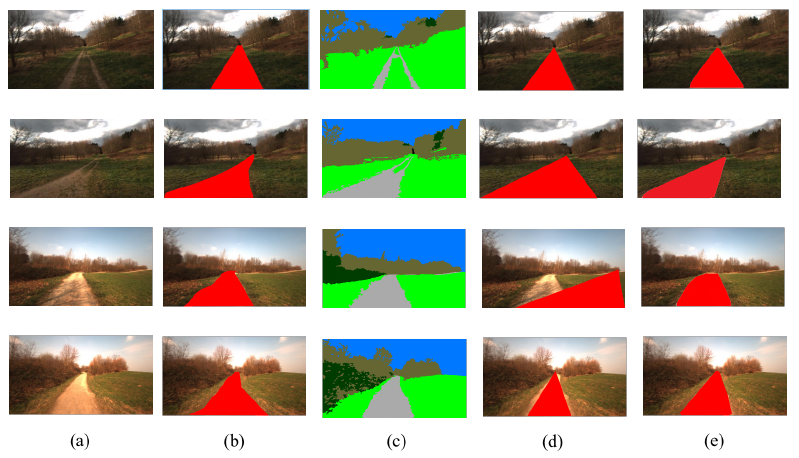
Figure 5. Qualitative results of road detection method. ( a ) Input image, ( b ) ground truth, ( c ) semantic result, ( d ) vanishing point result, ( e ) ARDformer result.